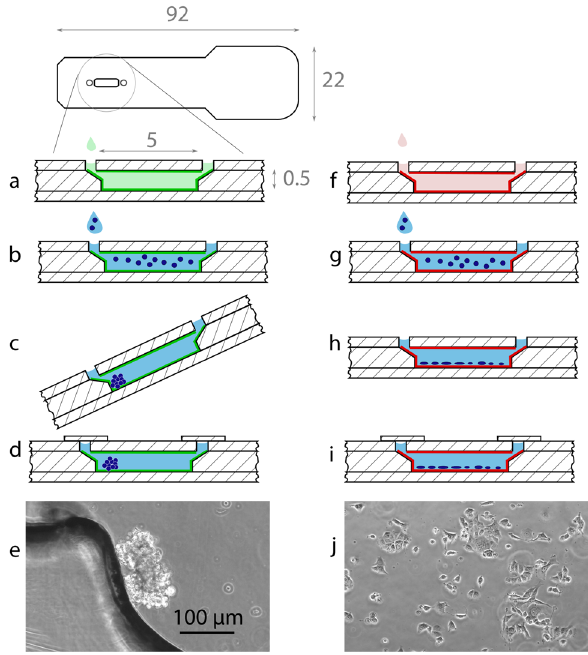
Figure 1. Schematic of the microfluidic device and sample preparation. The device is coated with pluronic F-127 ( a , dimensions in mm) or fibronectin ( f ). Then, cells are seeded in growth medium ( b,g ), and incubated for 4 h ( c,h ). The pluronic-coated device is held at an angle, allowing the cells to settle at the bottom ( c ). Finally, the devices are sealed with adhesive tape ( d,i ). Phase-contrast micrograph of the spheroid culture ( e ) and adherent monolayer ( j ) of 1800 cells in 2.5 µ L. ( e,j ) are the same scale.